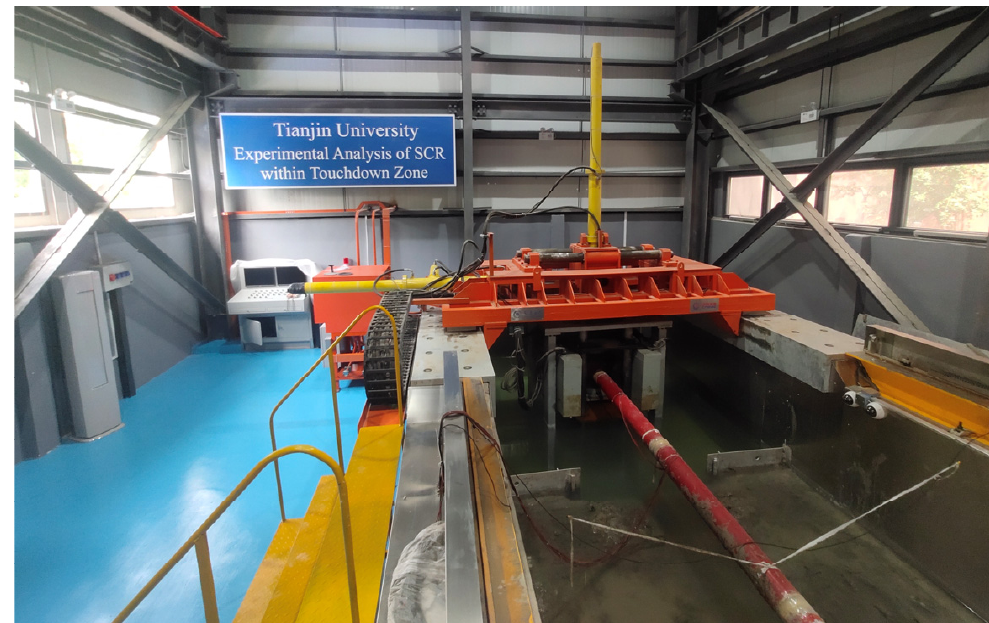
Figure 1. The layout of the test platform.